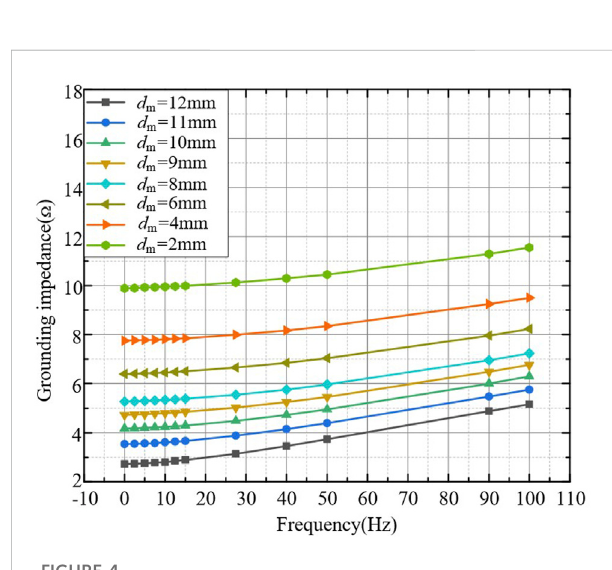
FIGURE 4 The amplitude-frequency characteristics of